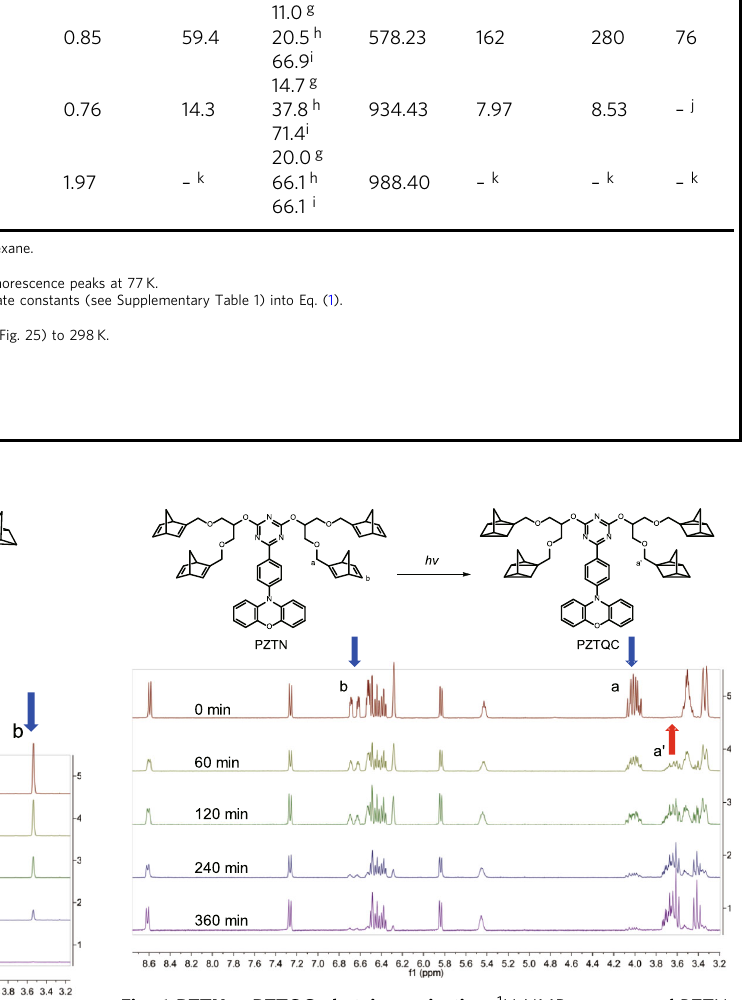
Fig. 6 PZTN → PZTQC photoisomerization. 1 H NMR spectrum of PZTN photoisomerization to PZTQC by exposure to a metal halide lamp (a bandpass fi lter between 350 and 450 nm) as a function of time (in cyclohexane-d 12